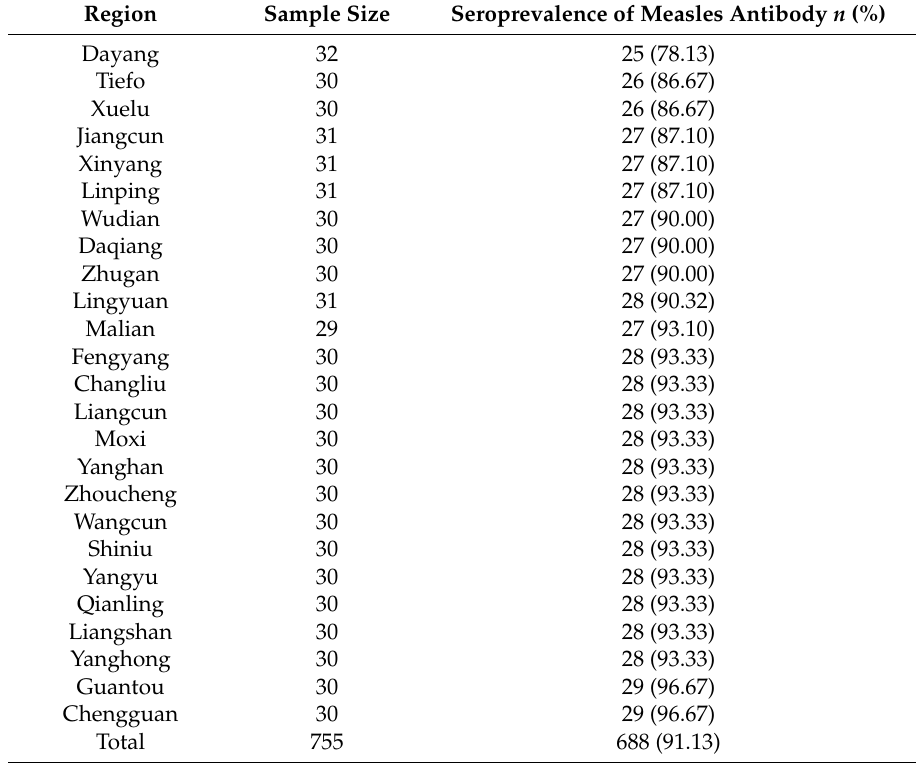
Table 1. Seroprevalence of the measles antibody in Qian County, China.